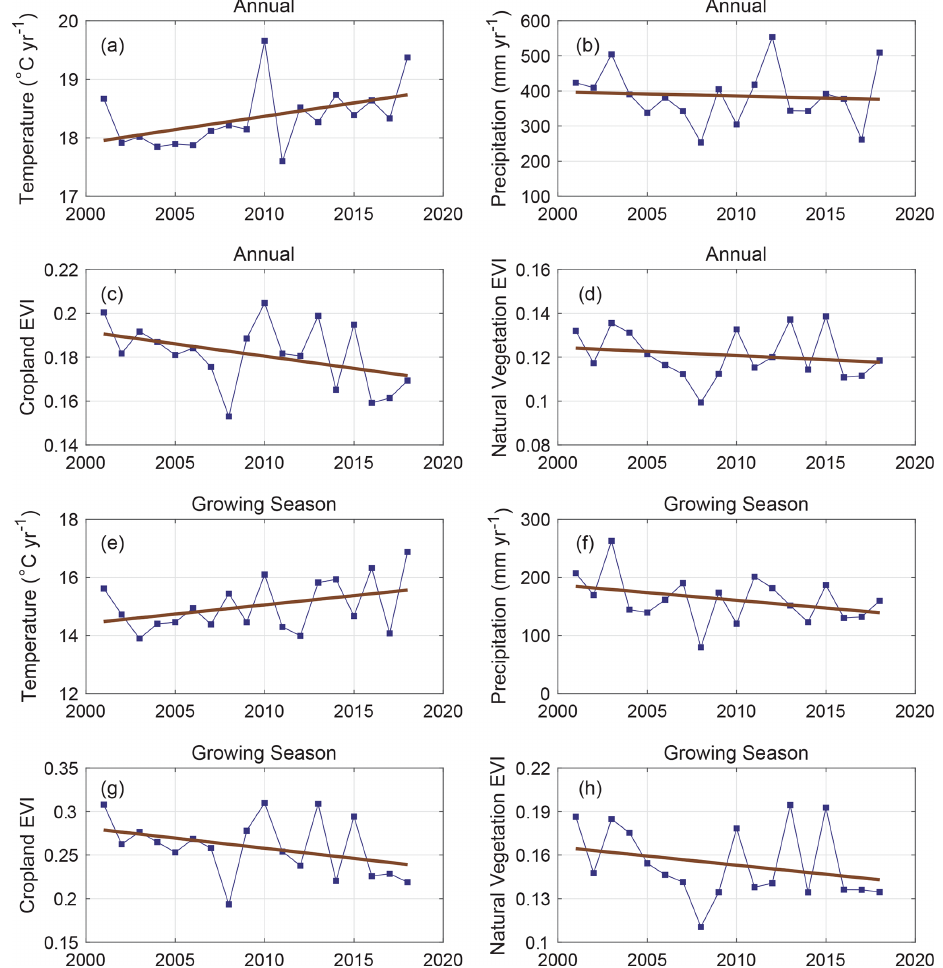
Figure 3. Interannual variations of climatic factors and vegetation during 2001–2018. (a) – (d) are annual averages of temperature, precipita- tion, cropland EVI and natural vegetation EVI. (e) – (h) are growing season (F–M) averages of temperature, precipitation, cropland EVI and natural vegetation